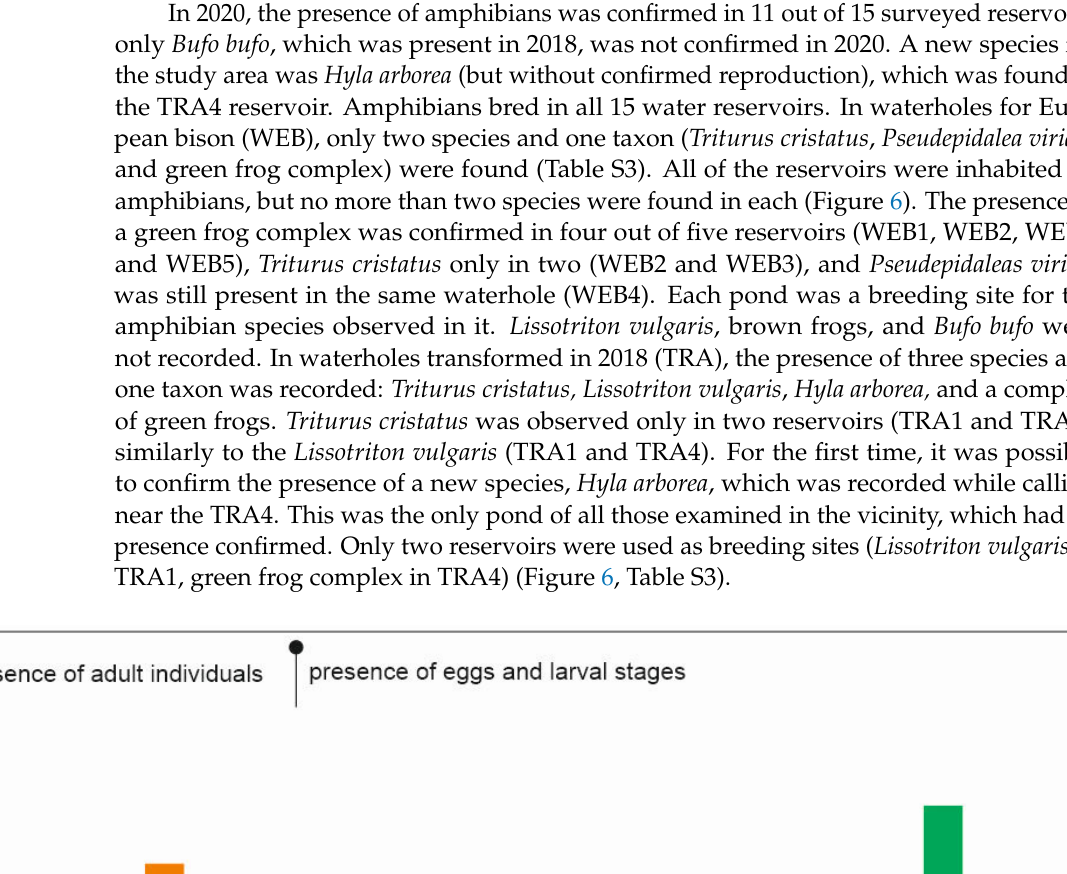
Figure 7. Number of bats species and individuals in given years of the study: 2018—before transformation to waterholes for European bison (SEM); 2019–2020—after transformation (TRA).